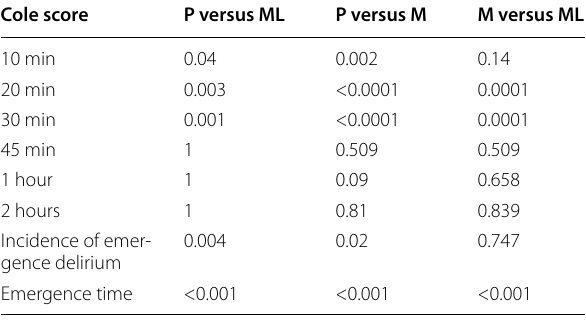
Values are presented as mean SD, * p value <0.05 statistically significant ± Table 5 Comparison of Cole score in intergroup